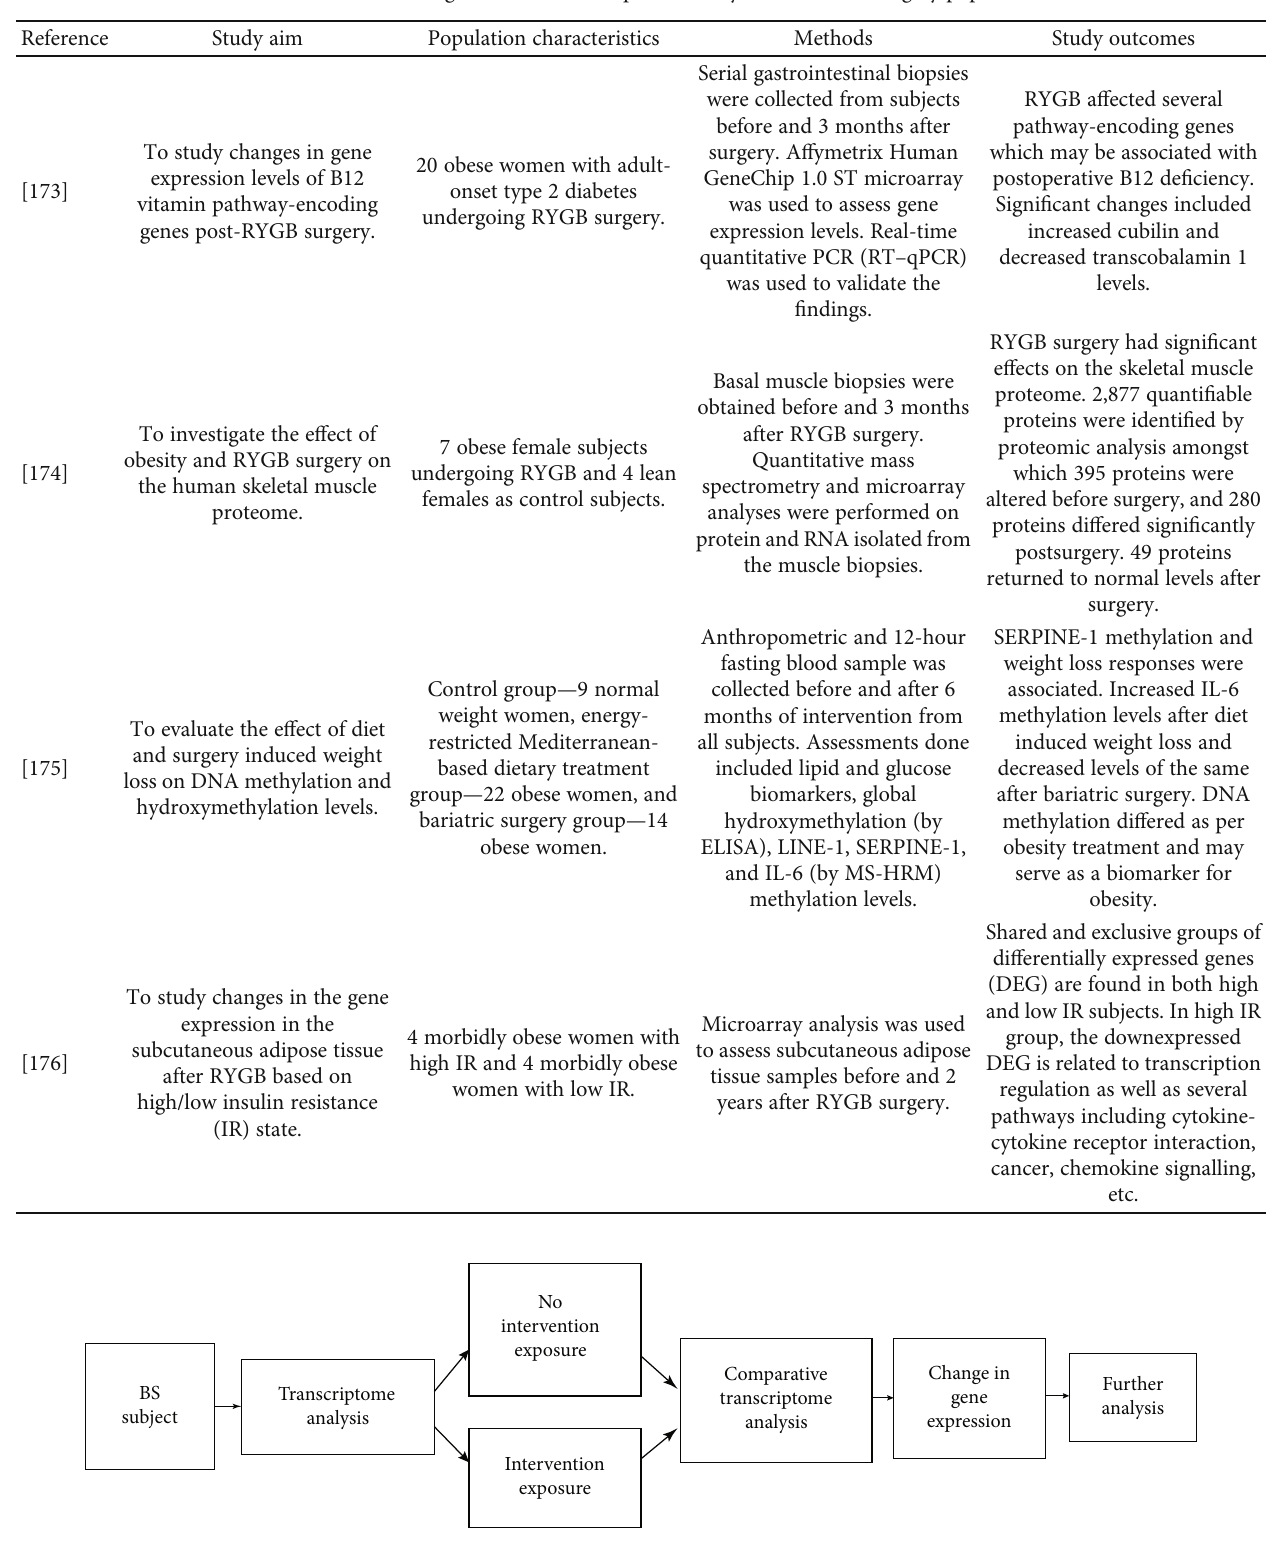
Table 3: Studies showing the use of transcriptomic analysis in bariatric surgery populations.